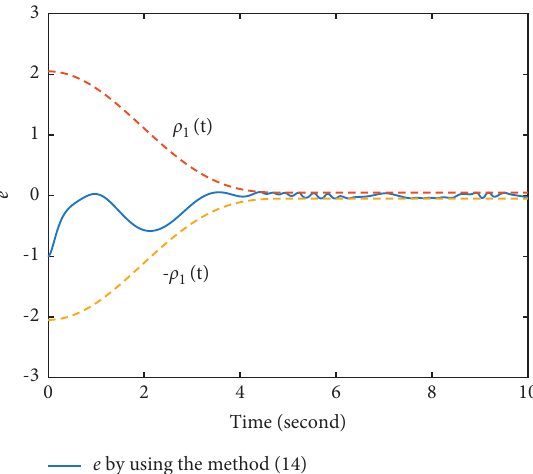
Figure 4: Time response trajectory of tracking error e by using ( t ) method (14) under ρ 1